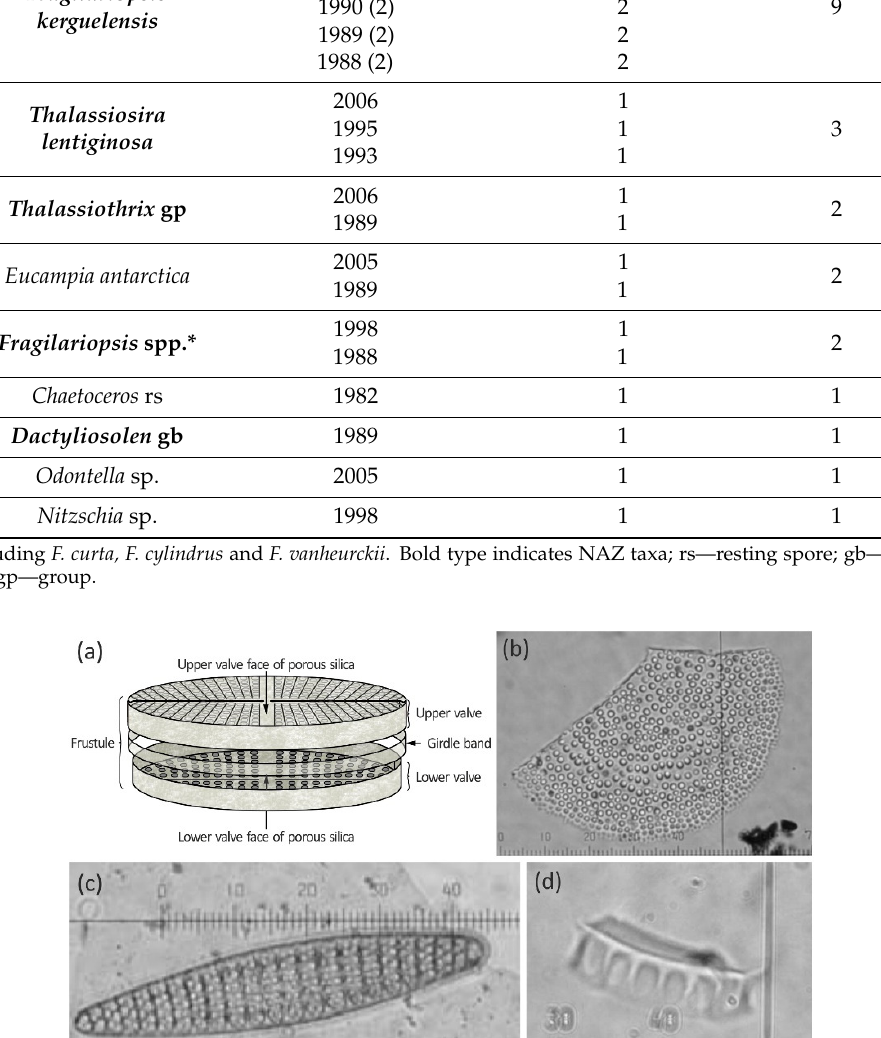
Figure 4. Diagram of oceanographic zones of the Southern Ocean (SAF—Subantarctic Front; APF— Antarctic Polar Front; SSIE—seasonal sea-ice extent; PSIE—perennial sea-ice extent; CP—Coastal Polynya). Coloured circles represent diatom productivity (increased density of circles corresponds to higher productivity); colours represent ecologically distinct diatom assemblages associated with the oceanographic zones (adapted from Allen et al. [59]). Table 1. Summary of diatom identifications. Diatom Taxa